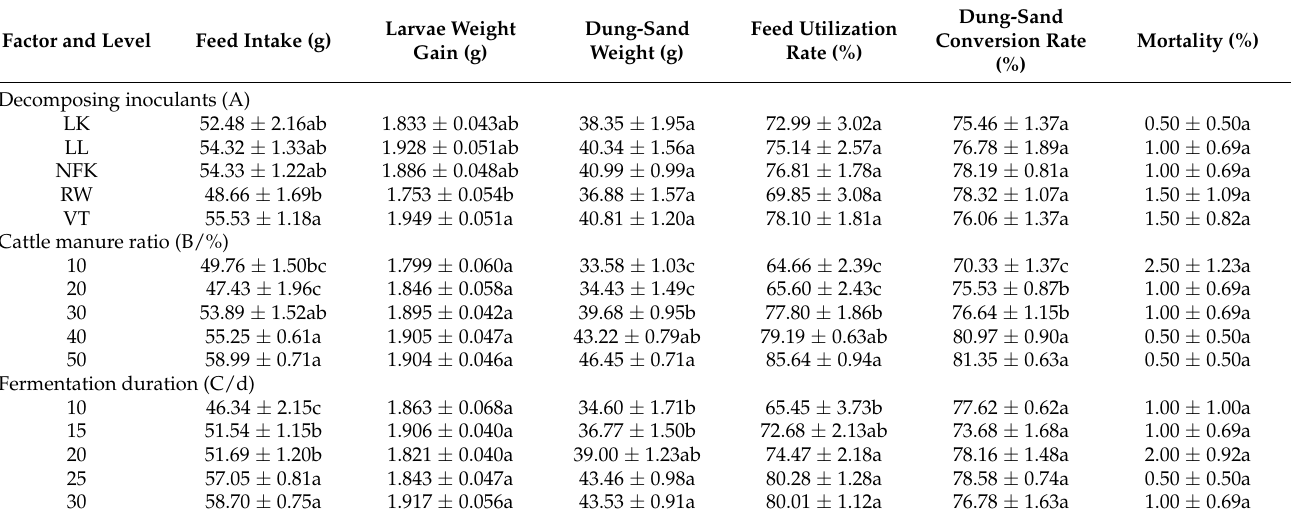
Table 5. Effect of the decomposition inoculant, cattle manure ratio, and fermentation duration on the transformation capability of the 3rd instar larvae of P. brevitarsis .